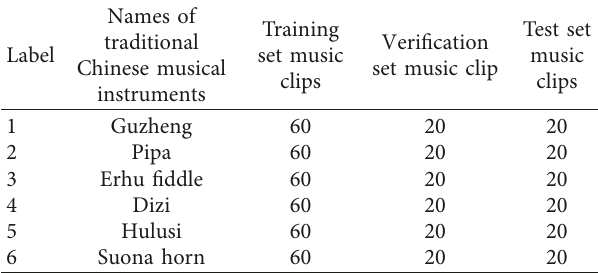
Figure 4: Extraction process of MPC feature parameters. Table 3: Database information of Chinese traditional musical